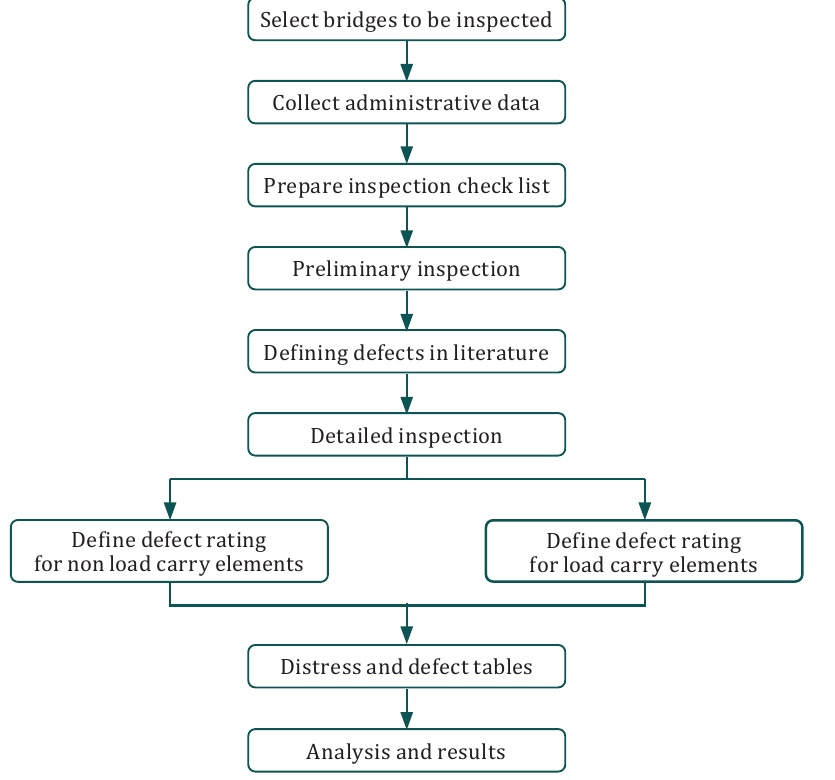
Figure 3. Outline of the methodology